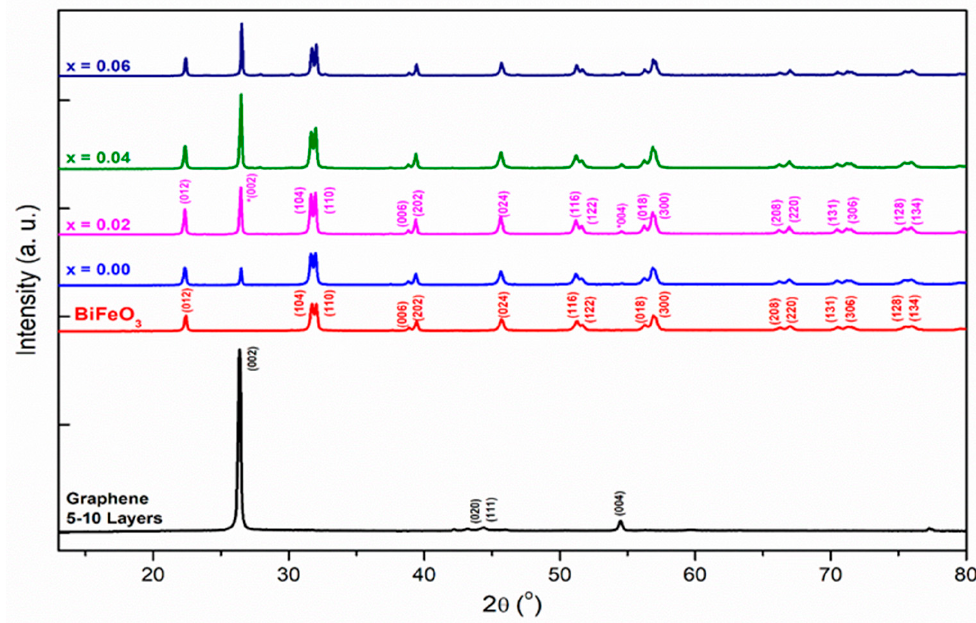
Figure 1. XRD patterns of graphene 5–10 layers, BiFeO 3 nanoparticles, and [BiFe 1 − x Li x O 3 ]-graphene nanocomposite.